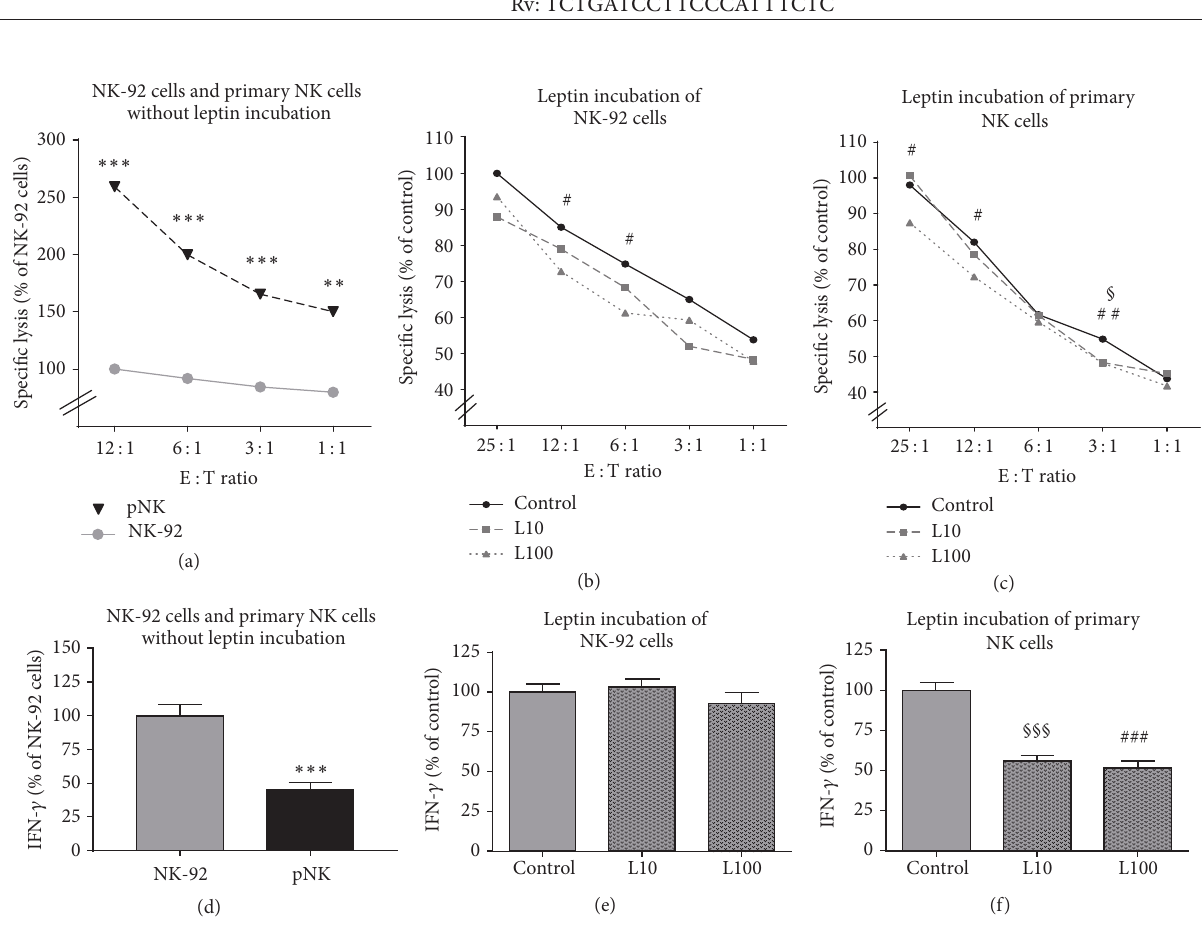
Figure 1: Cytotoxicity assay (a–c) and IFN- 𝛾 secretion (d–f) of NK-92 or primary NK (pNK) effector cells [E] against DLD-1 colon tumor cells target cells [T]. (a) Cytotoxicity assay of unstimulated NK-92 cells and unstimulated pNK cells. (b and c) Cytotoxicity assay of NK-92 cells or pNK cells after leptin incubation with 10ng/mL (L10) or 100ng/mL (L100) leptin for 72 h. Values are expressed as means ± SEM of at least three individual experiments with each 𝑁 = 3 -4 well. (d) Interferon– 𝛾 (IFN- 𝛾 ) secretion of unstimulated NK-92 cells and unstimulated pNK cells. (e and f) IFN- 𝛾 secretion of NK-92 cells or pNK cells after leptin incubation. Values are expressed as means ± SEM at least in three individual experiments. ∗∗ 𝑃 < 0.01 and ∗∗∗ 𝑃 < 0.001 , NK-92 cells compared to pNK cells; § 𝑃 < 0.05 , §§§ 𝑃 < 0.001 , control group versus L10; # 𝑃 < 0.05 , ## 𝑃 < 0.01 , and ### 𝑃 < 0.001 , control group versus